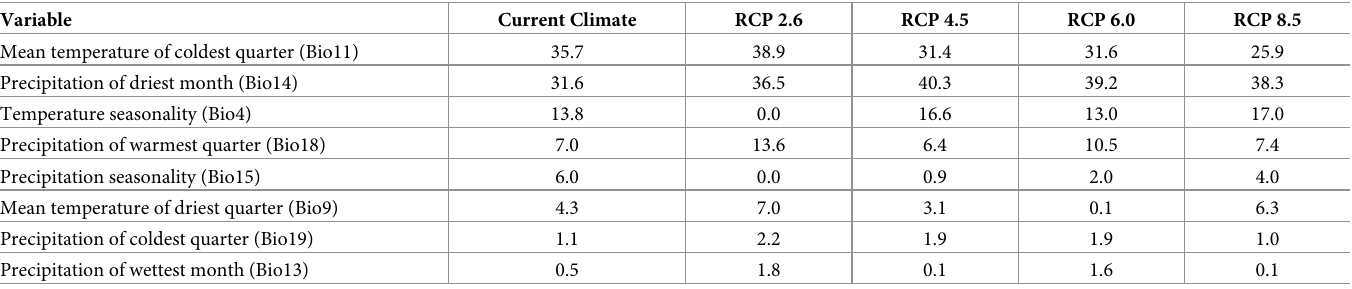
Table 3. Contribution (%) of the eight bioclimatic variables [56] to the climatic suitability models. Variable